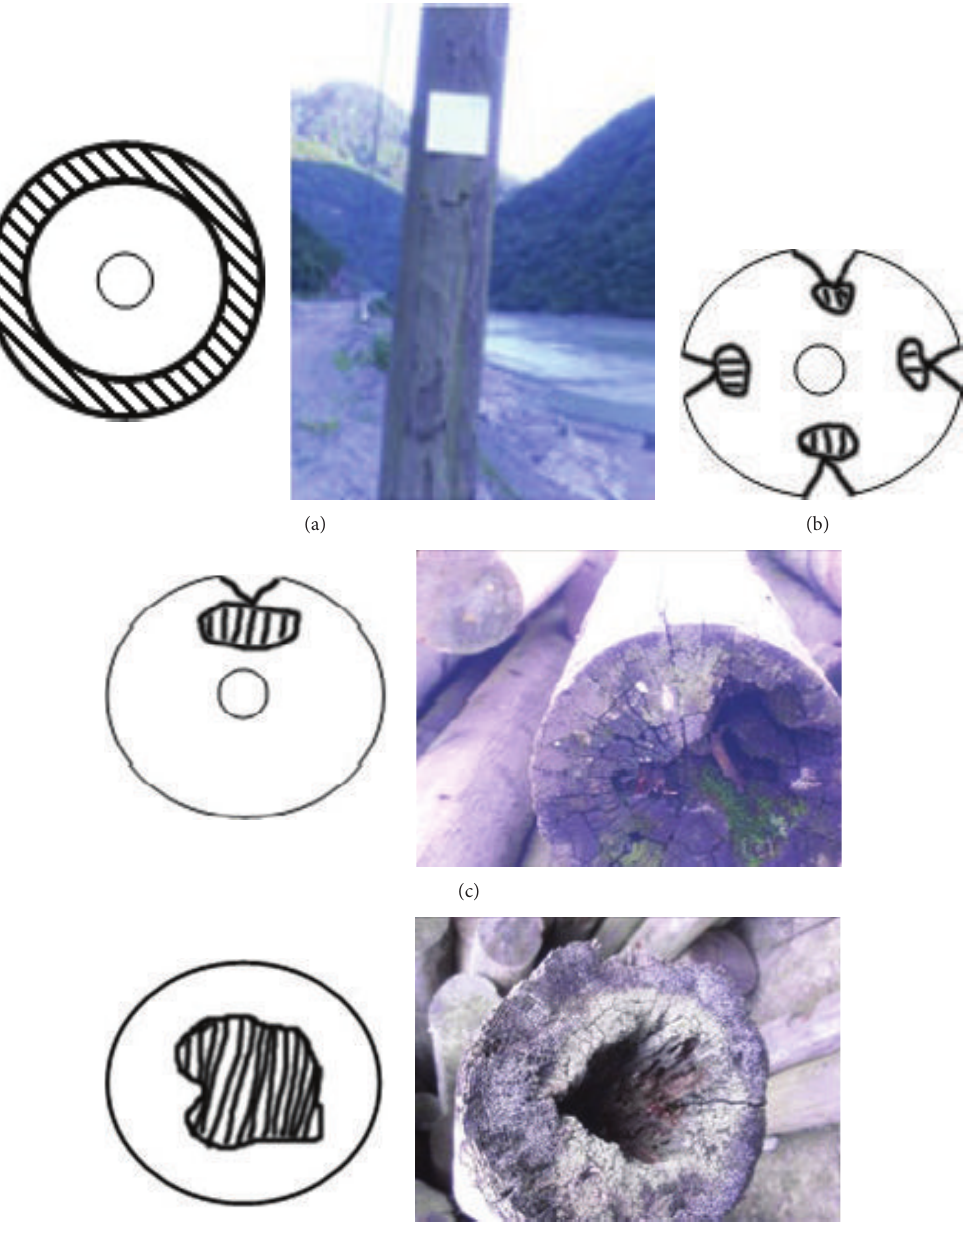
Figure 4: Decay patterns observed on utility poles. (a) Surface decay. (b) Small decay pockets associated with checks. (c) A large decay pocket associated with a check. (d) Hollow-type decay.